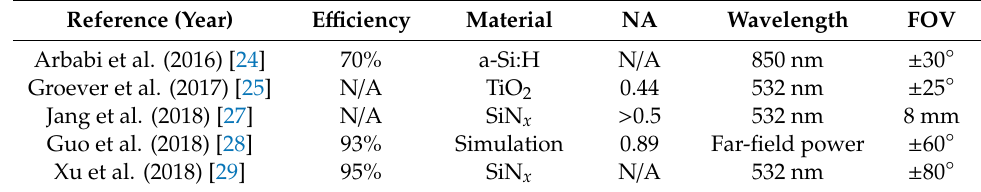
Table 1. Comparison between each fabricated metasurface-based lens in wide angular FOV design.